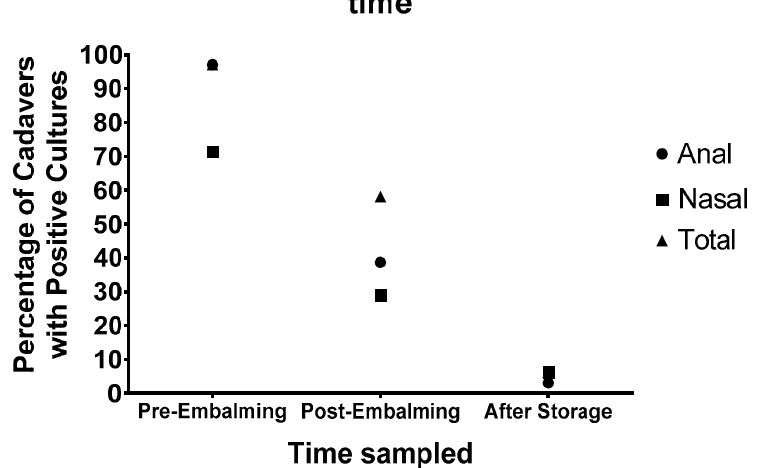
Figure 4. Effect of microbial growth on embalmed cadavers over time. Cadavers were swabbed multiple times in the same areas, following different points in the embalming process. Pre-embalming is when the cadavers arrive at the facility (n = 35). Post-embalming sample collection occurred 24 h after embalming was performed (n = 31). After storage, the cadavers were removed from 4 °C and stored in the teaching laboratory (n = 32). A positive cadaver is one that has had growth in any of the agar plates for the sample. The total is the number of cadavers with growth from either anal or nasal samples.